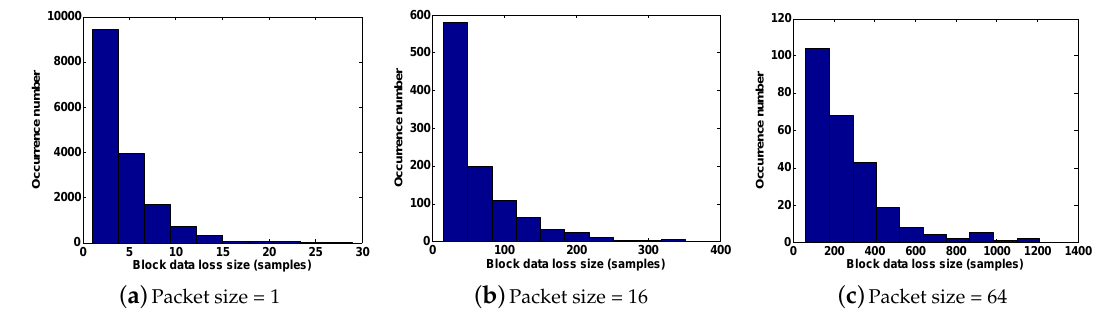
Figure 4. Histograms of the occurrence number for different sizes of block data loss under different packet